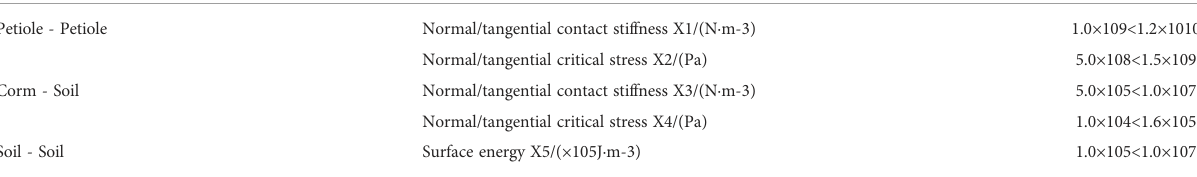
TABLE 3 Parameter range of particle contact model. Interparticle contact parameters